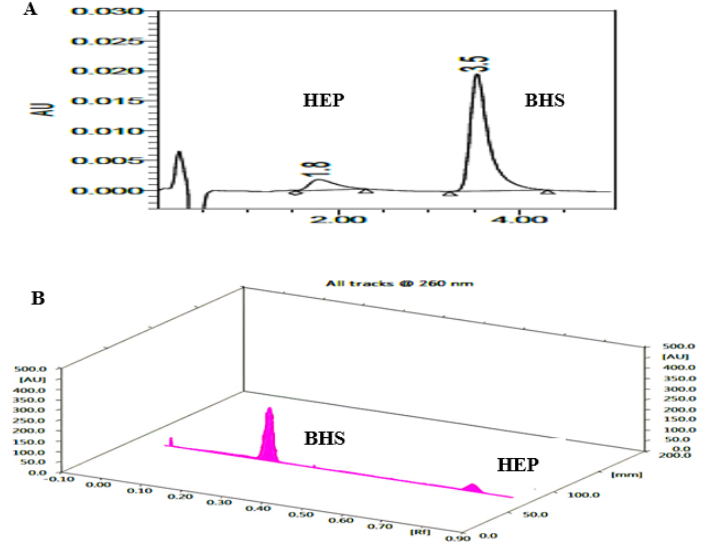
Figure 2. Separation chromatograms of the analyte mixtures under study using the proposed methods, where ( A ) HPLC (5.0:0.5 µg mL −1 , BHS/HEP) and ( B ) HPTLC (5000.0:50.0 ng per band, BHS/HEP). Table 2. Linearity and regression results for the determination of BHS and HEP using the proposed